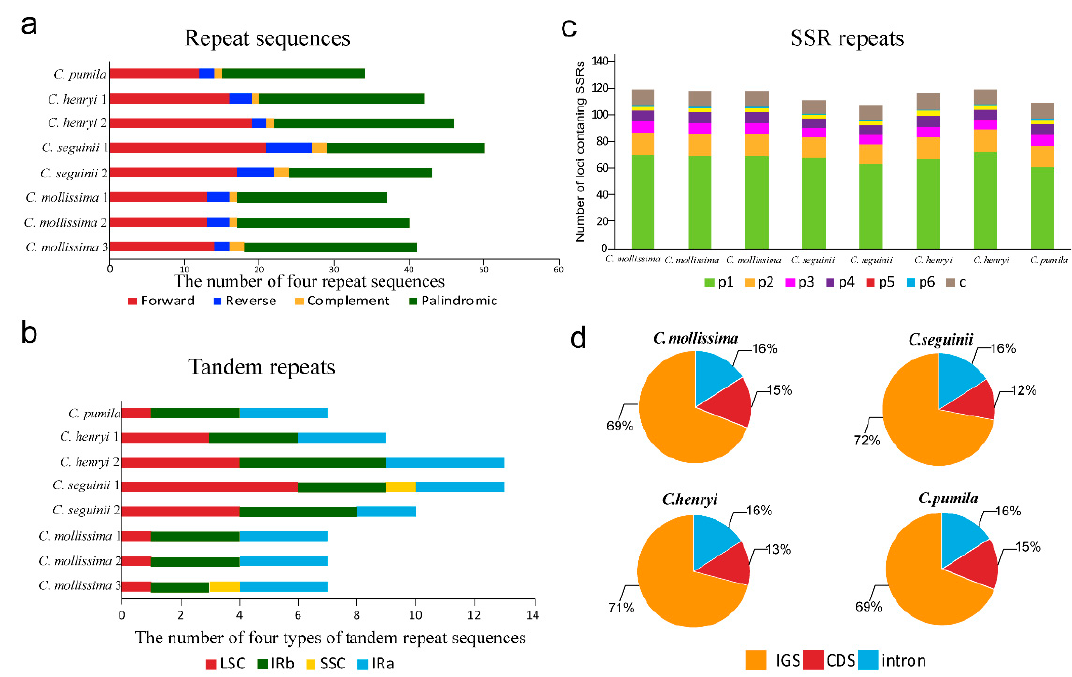
Figure 3. Analysis of repeated sequences in four Castanea species’ cp genomes. ( a ) Long repeat sequences of at least 30 bp with a sequence identity ≥ 90%. ( b ) Tandem repeats of at least 10 bp in cpDNA. ( c ) Number of loci containing SSR repeats (simple sequence repeats) in Castanea individuals. ( d ) Distribution of SSR repeats in the intergenic regions (IGS), coding regions (CDS), and introns of each Castanea species. “p1”, “p2”, “p3”, “p4”, “p5”, “p6” and “c” refer to mononucleotide, dinucleotide, trinucleotide, tetranucleotide, pentanucleotide, hexanucleotide, and complex nucleotide repeats.